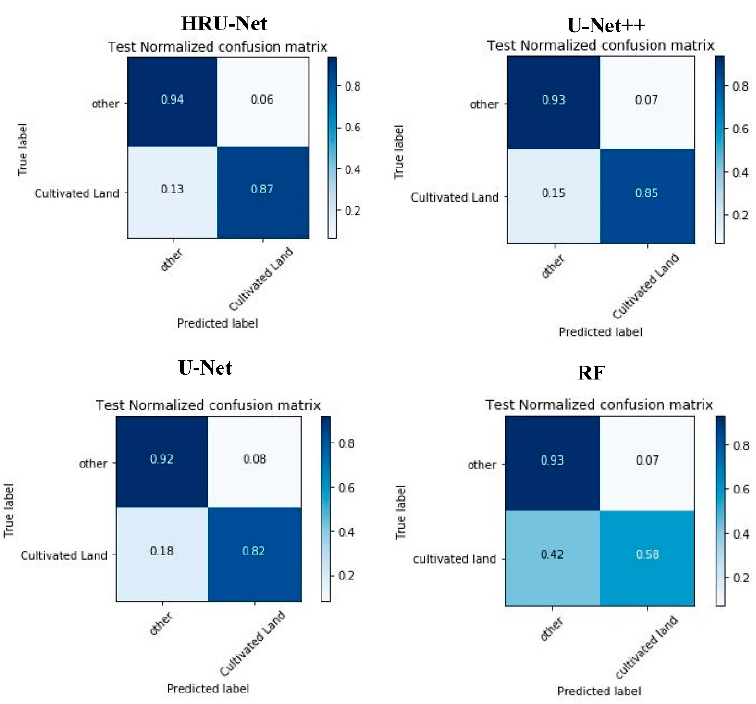
Figure 6. Confusion matrix for the HRU-Net, U-Net++, U-Net, and RF models over the independent test dataset for the Landsat TM-All dataset . Table 7. The time consumption and network complexity of the training of the HRU-Net, U-Net++, and U-Net.